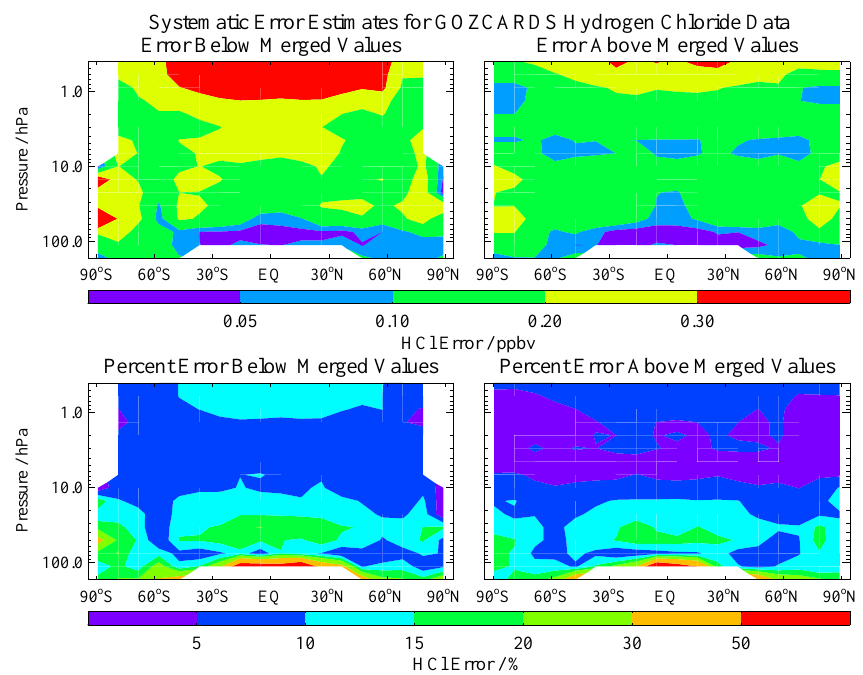
Figure 6. Systematic error estimates for GOZCARDS HCl. One error (left panels) is relevant for values lower than (below) the merged values, and one (right panels) for values larger than the merged values; the top panels give the error estimates in ppbv, and the bottom panel errors are expressed as percent of the average merged values over the relevant time periods (see text). These error bars provide a range within which 95% of the source data values